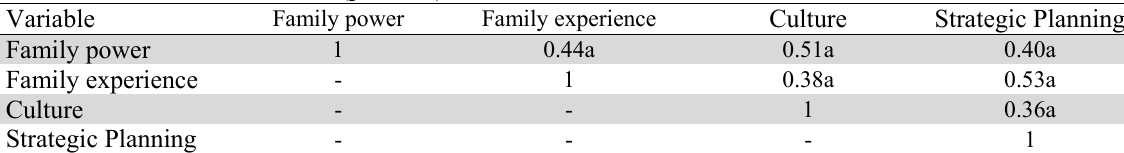
Correlation between variables (p <0.01) Variable Family power Family